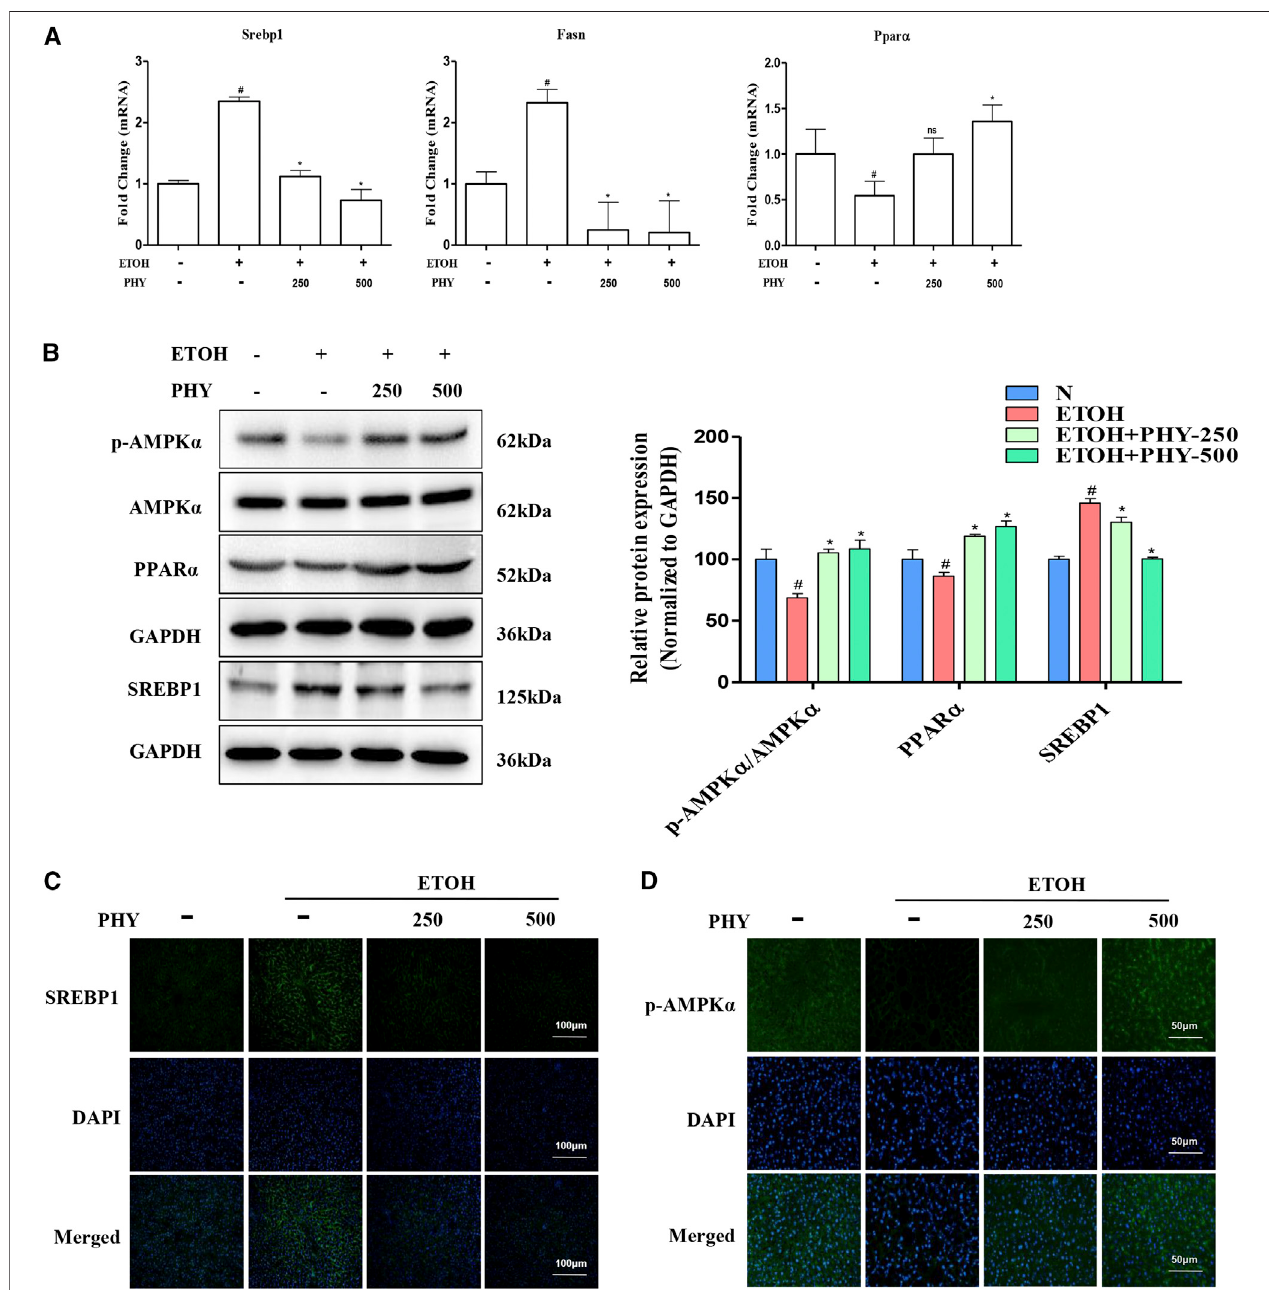
FIGURE 2 | Physcion effectively reduce the lipogenesis induced by ethanol. (A) The mRNA expression of Srebp1, Fasn, and Ppar α . (B) The protein expression of AMPK α , p -AMPK α , PPAR α , and SREBP1. (C) Immuno fl uorescence staining of SREBP1 ( × 400 original magni fi cation). (D) The phospho-AMPK α staining (green) and nuclei with DAPI (blue) are shown. Values signi fi cantly different from the control are indicated by hash signs ( # p < 0.05). Values signi fi cantly different from the ethanol are indicated by asterisks (* p < 0.05).